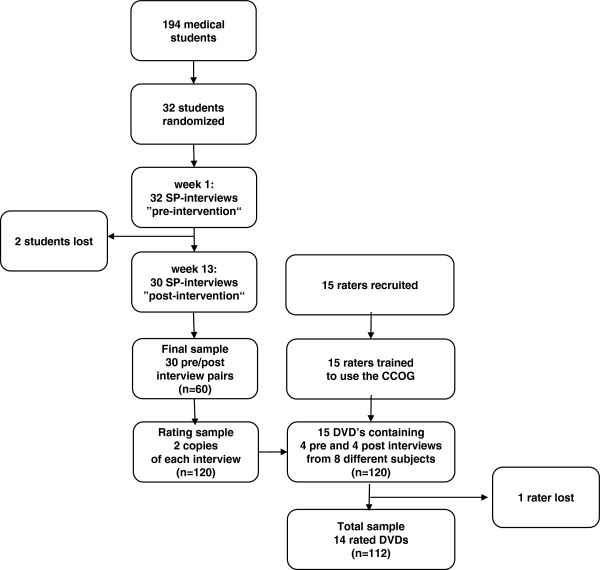
Flowchart to show the sequential steps in this study from selection, randomization and assessment of students (SP: simulated patient).